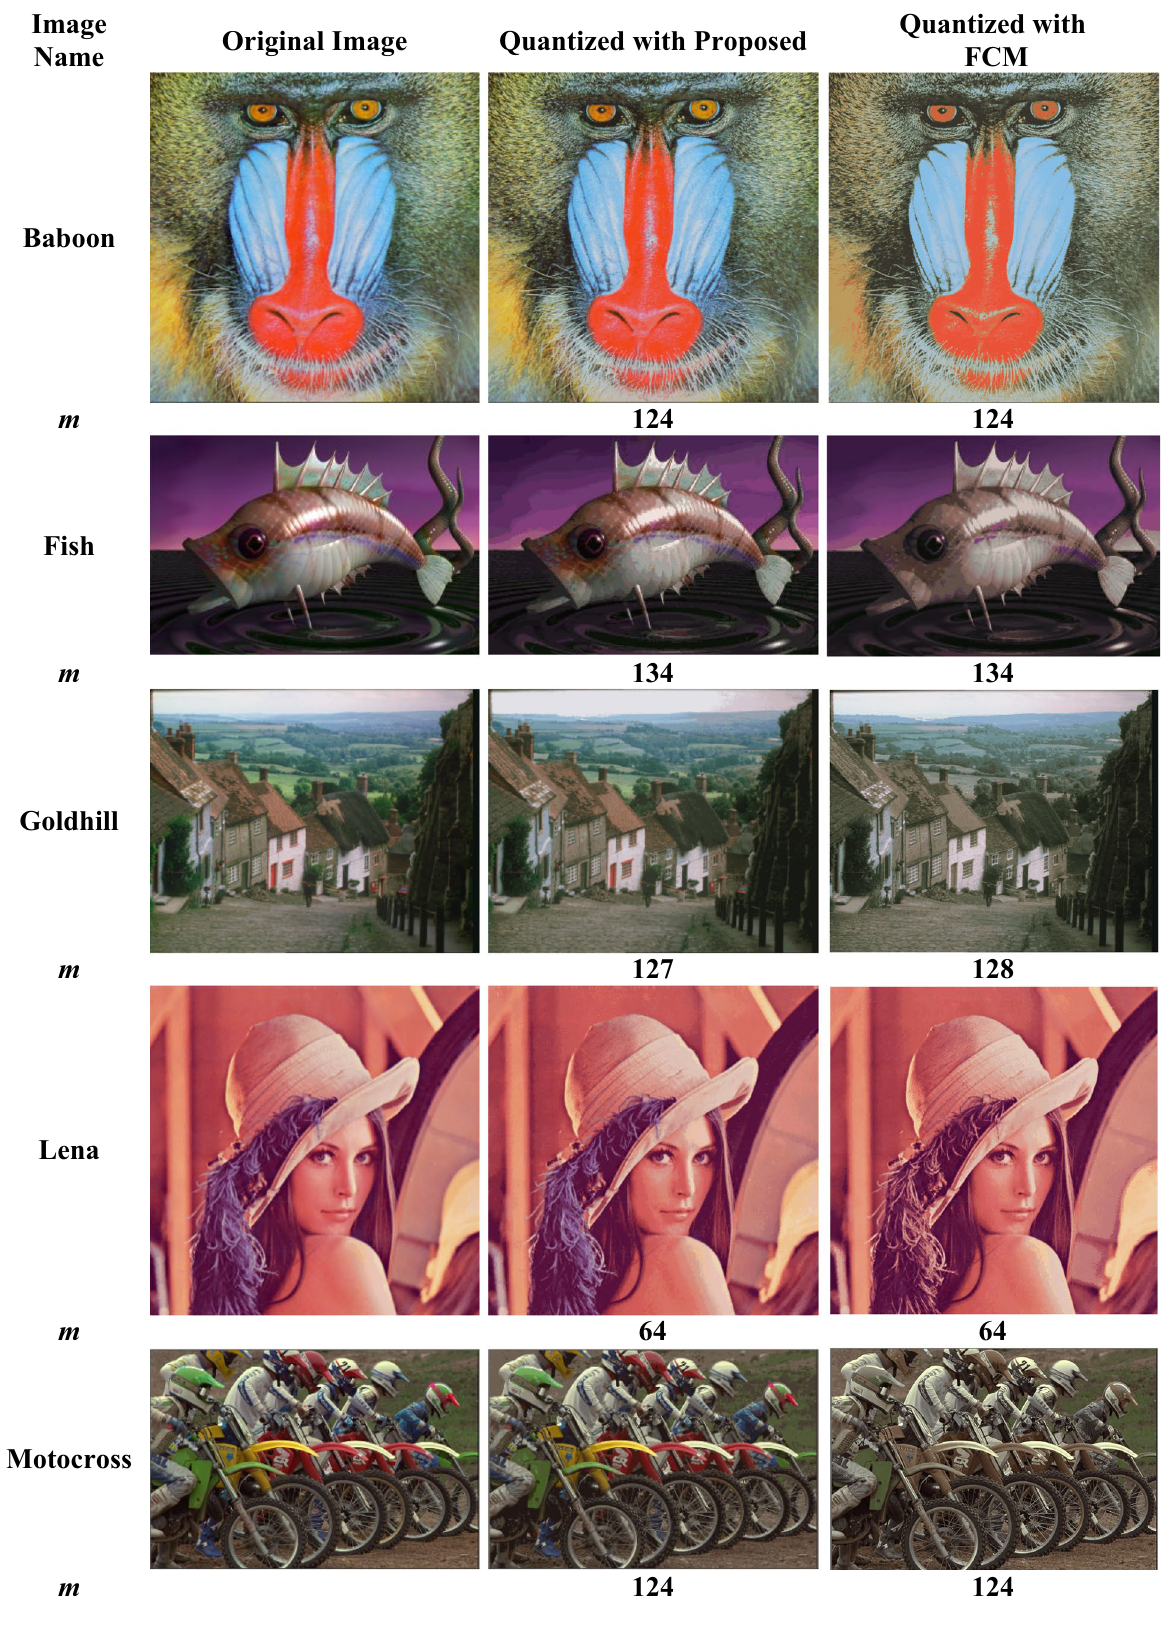
Fig. 6 Common color quantization test images and quantized outputs with FCM and proposed